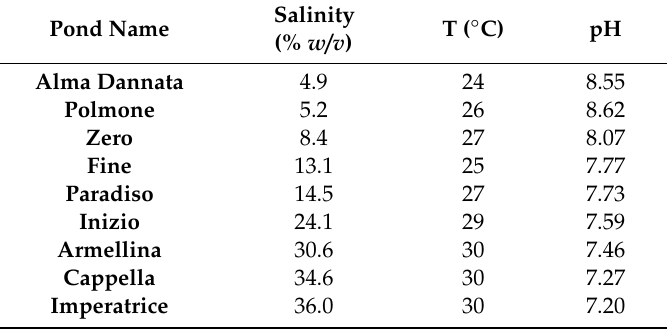
Table 1. Names and properties of collected water